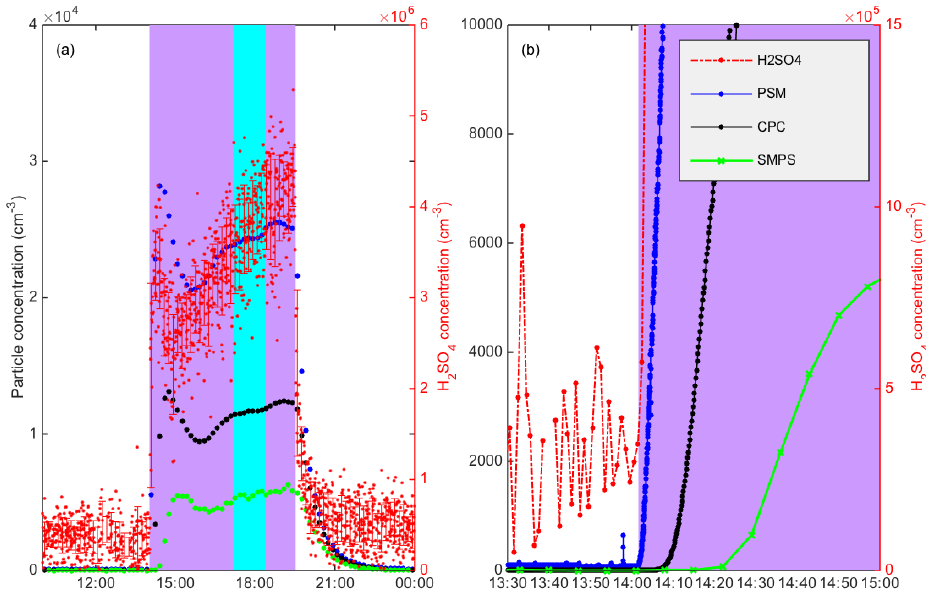
Figure 3. (a) A time series of PSM (blue markers), CPC (black), and CIMS (red) data at the start of one event. The purple area illustrates the time period that UV light was switched on in the reaction chamber. The area shaded blue is the steady-state period from which the particle formation rate was obtained. Sub-figure (b) shows the zoomed-in time delay of particle formation after turning the UV light on, which was used to verify that particles are measured very close to their formation